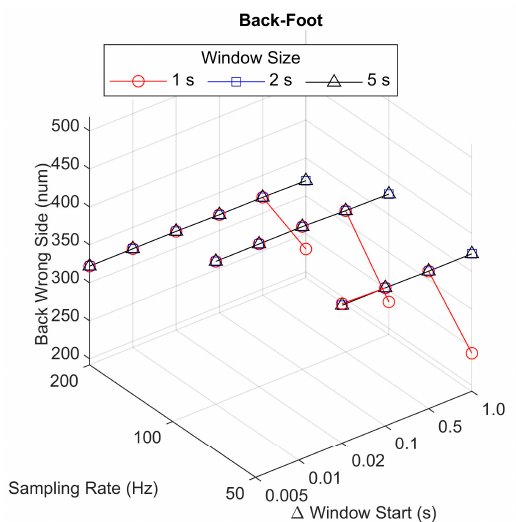
Figure 5. Number of steps (out of a mean of 1942 recorded steps) in which the back accelerometer method assigned the wrong step among different sampling rate, window size, and change in window start time parameters. The number of incorrect step side assignments was determined based on the back-foot comparison.